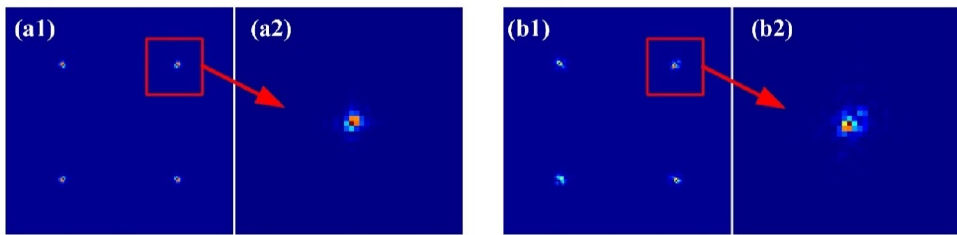
Figure 5. The spot array image and single sub-spot. ( a1 , a2 ) The spot array image and sub-spot from SHWFS. ( b1 , b2 ) The spot array image and sub-spot from FBPM-SHWFS.